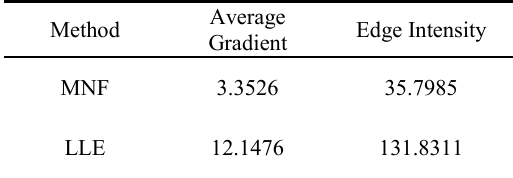
Table 1. Comparison of image information after LLE and